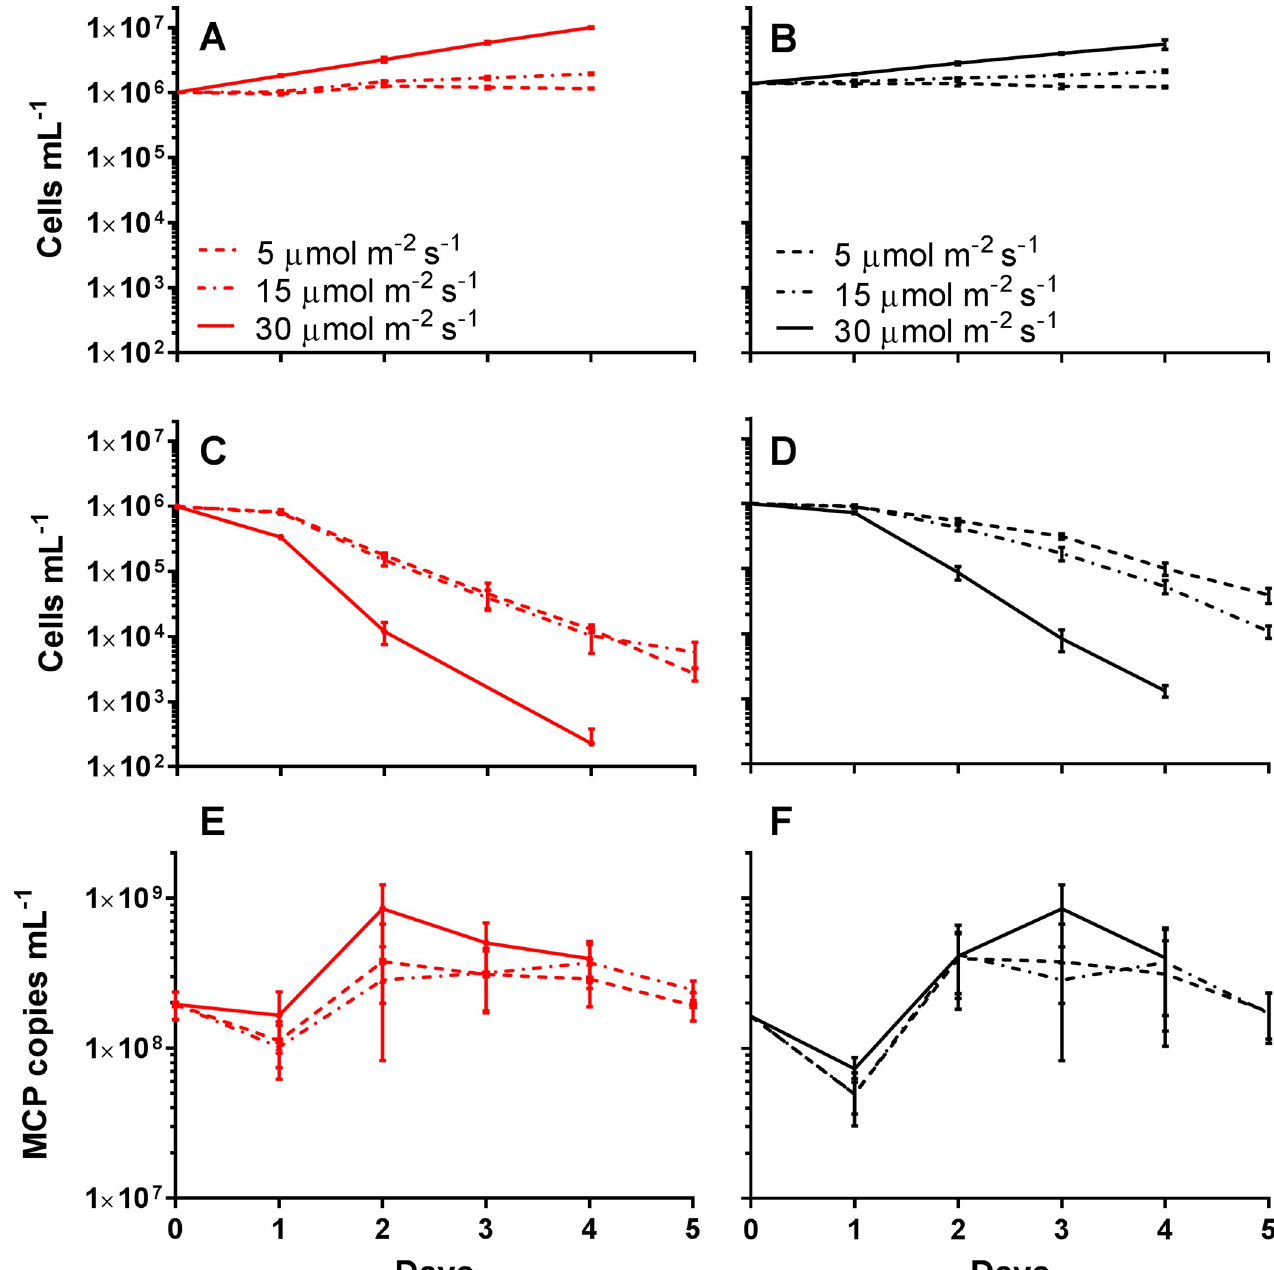
Fig 3. Aureococcus anophagefferens virus infection cycle dynamics with acclimation to varying light levels and in lower light. A . anophagefferens host concentrations for uninfected cultures acclimated to A) 90 μ mol photons m -2 s -1 and B) 30 μ mol photons m -2 s -1 , and infected cultures acclimated to C) 90 μ mol photons m -2 s -1 and D) 30 μ mol photons m -2 s -1 over the 5-day experiment. MCP copies mL -1 for cultures acclimated to E) 90 μ mol photons m -2 s -1 and F) 30 μ mol photons m -2 s -1 over the 5-day experiment. Cultures were infected on day 0. Solid lines indicate acclimated cultures maintained at acclimated irradiance levels after infection, dotted and dashed lines indicate acclimated cultures transferred into 15 μ mol photons m -2 s -1 light after infection, and dashed lines indicate acclimated cultures transferred into 5 μ mol photons m -2 s -1 light after infection. All symbols are for n = 5 five biological replicates ± SD.